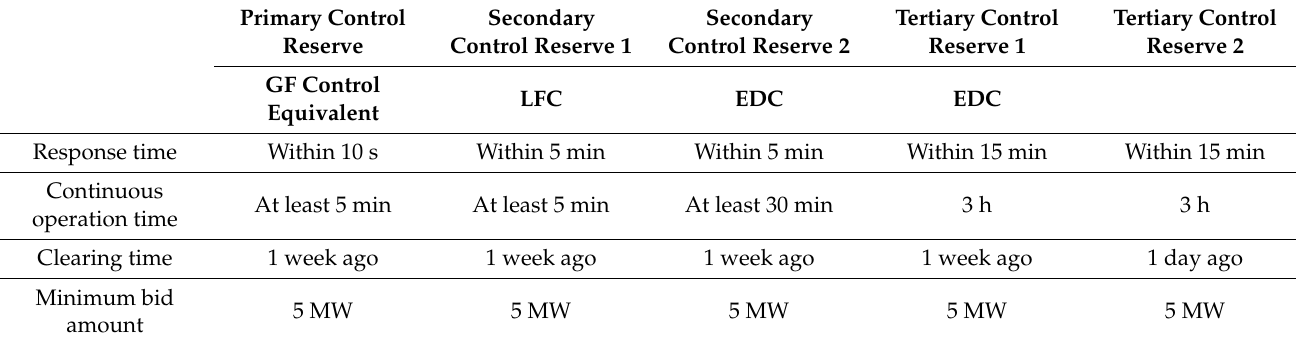
Figure 1. The structure of the VPP. Table 1. Japanese BC market’s requirement [25].